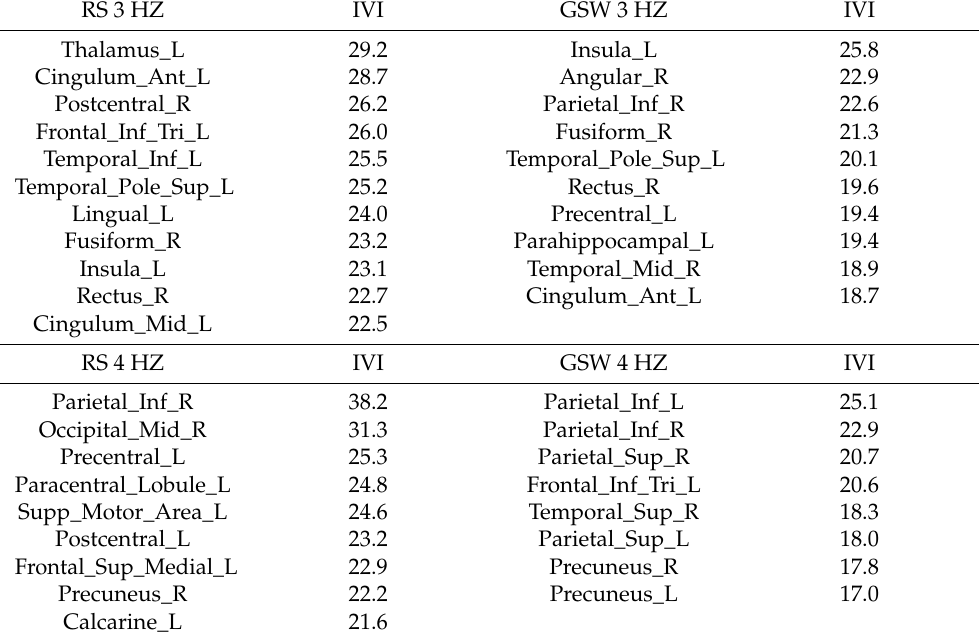
Table 3. Integrated Value of